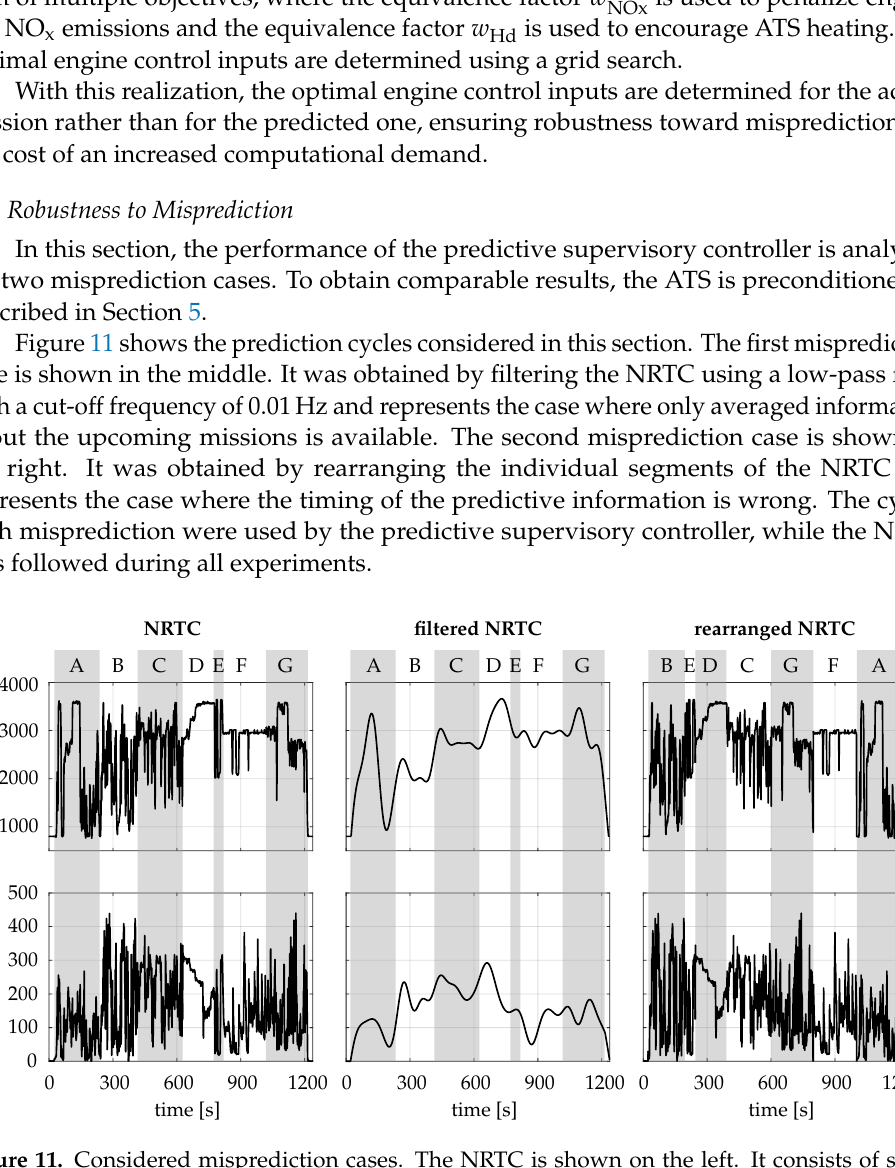
Figure 11. Considered misprediction cases. The NRTC is shown on the left. It consists of seven segments that describe the operation of different nonroad applications [27]. These segments are visualized by the gray areas and assigned a capital letter to illustrate their order. The filtered NRTC is shown in the middle. The rearranged NRTC is shown on the